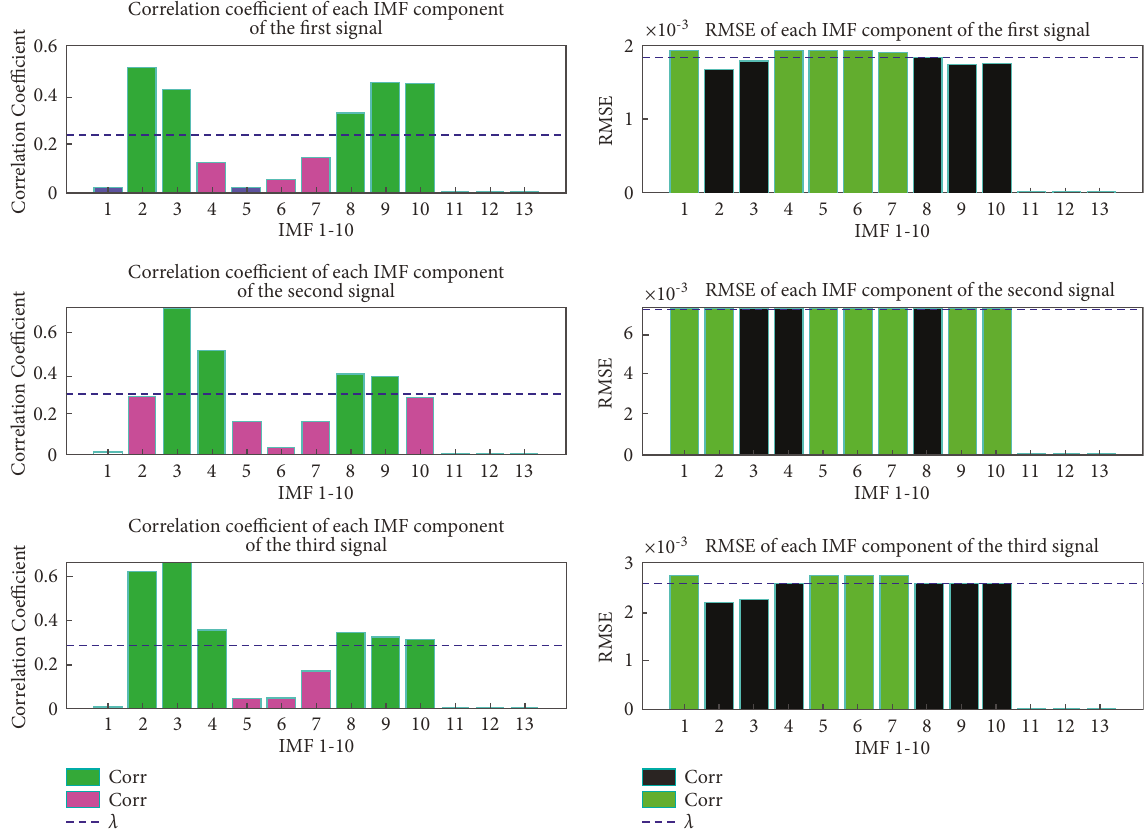
Figure 23: The process of adaptively selecting IMF